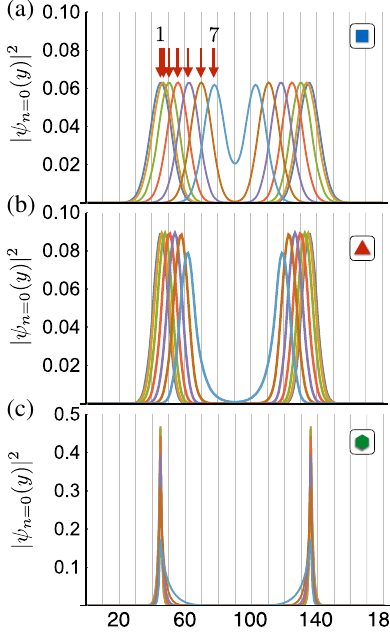
FIG. 3. Plot of the support of the wave function, as a function of y , of selected zero-energy states corresponding to the spectra shown in Fig. 1. Panels (a), (b), and (c) correspond to leftmost, middle, and rightmost panels of Fig. 1, respectively (graphically indicated by the square, triangle, and hexagon). Here, in each panel, the seven different curves correspond to different values of k , which are indicated by solid black dots in Fig. 1 and red x arrows in (a). Two pseudo-Landau orbitals correspond to each value of k , as is most clearly seen in (a). This matches the x degeneracy of n ¼ 0 pseudo-Landau levels and is consistent with the number of Fermi arcs: one Fermi arc per boundary. Note that as compared to the bottom row of Fig. 2, the Landau orbitals centered in the region where b x ð y Þ < m are absent, which explains the difference in degeneracy (twofold vs fourfold as discussed in the main